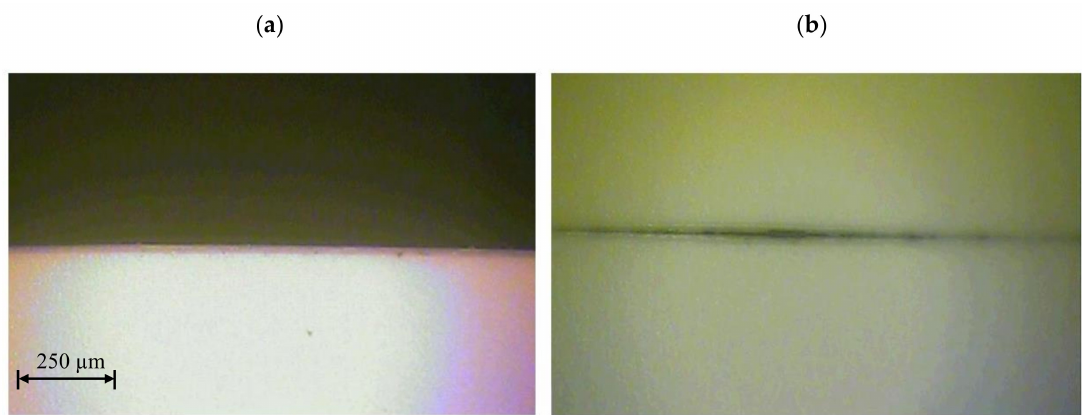
Figure 7. View of the cut surface of foil with thickness t = 70 µ m: ( a ) v = 0.222 m / s, f = 39 kHz, ( b ) v = 1.28 m / s, f = 39 kHz.